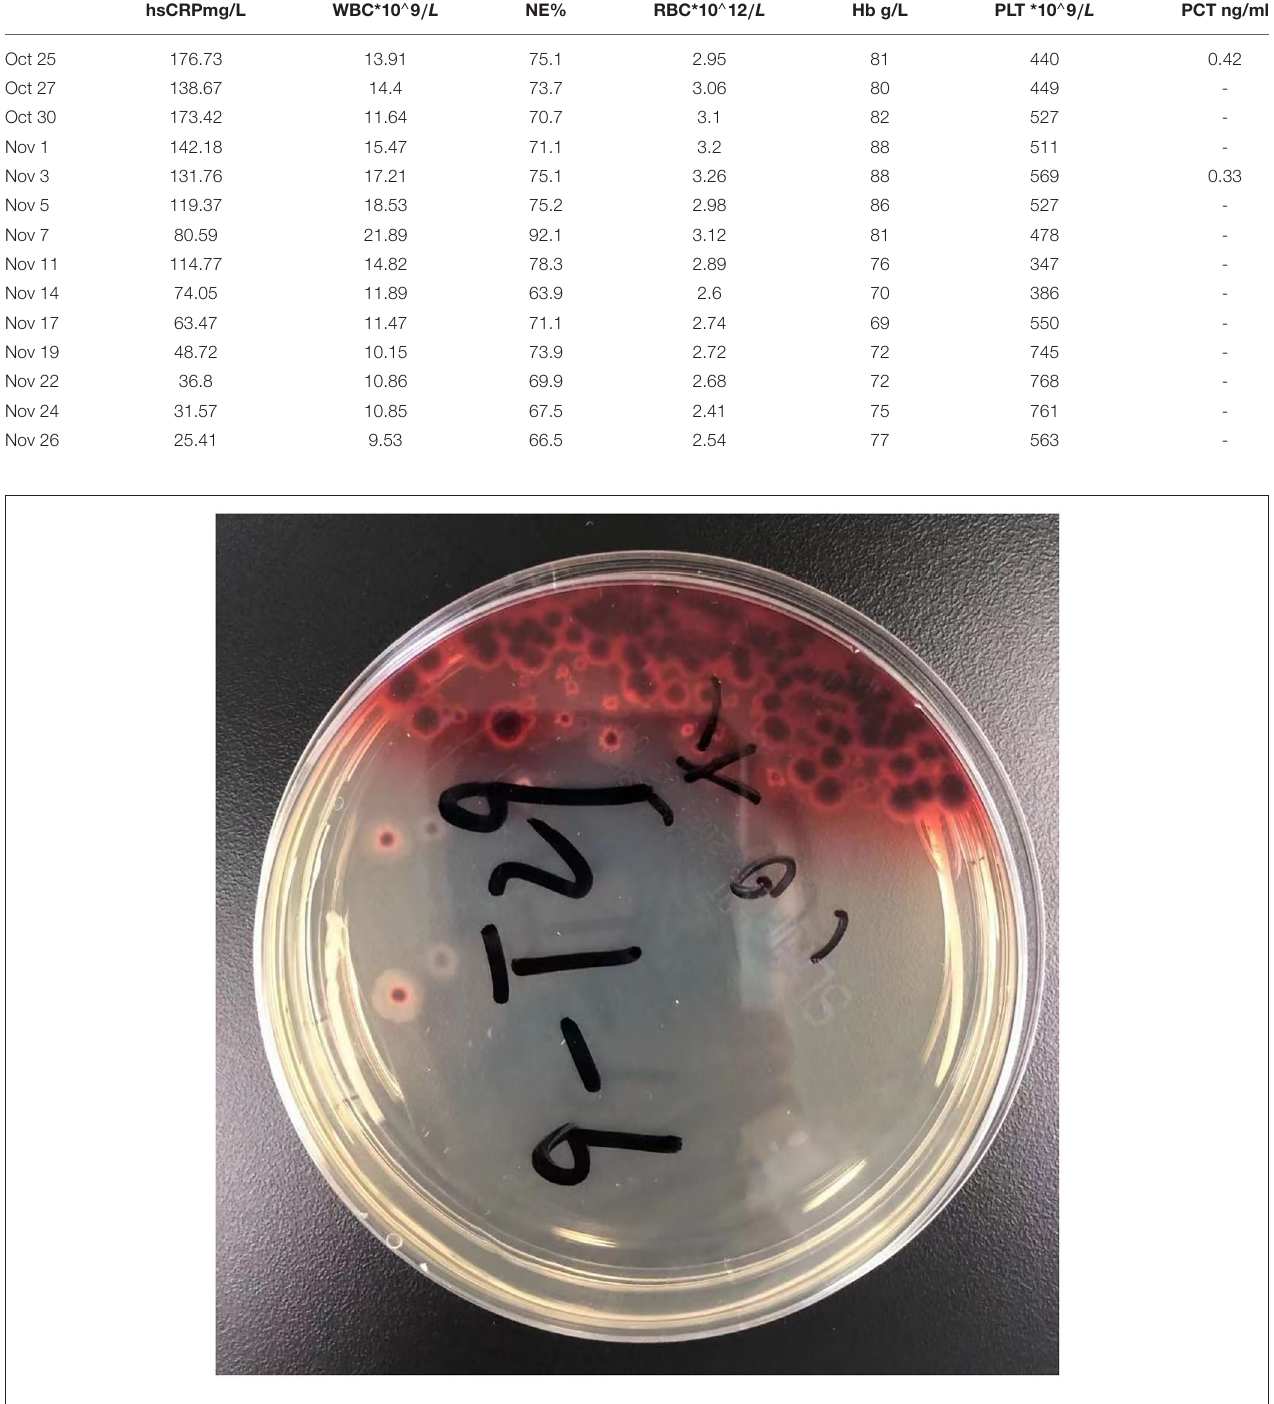
FIGURE 3 | The result of prolonged sputum culture. A diffusible red pigment produced by Talaromyces marneffei , diffuses to the surrounding medium.